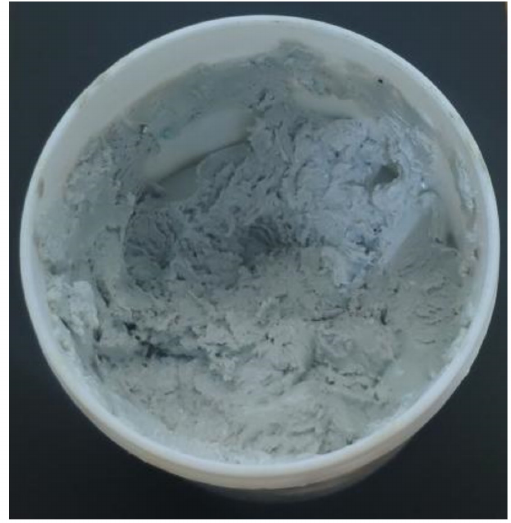
Figure 1. The physical appearance of plastic steel soil.